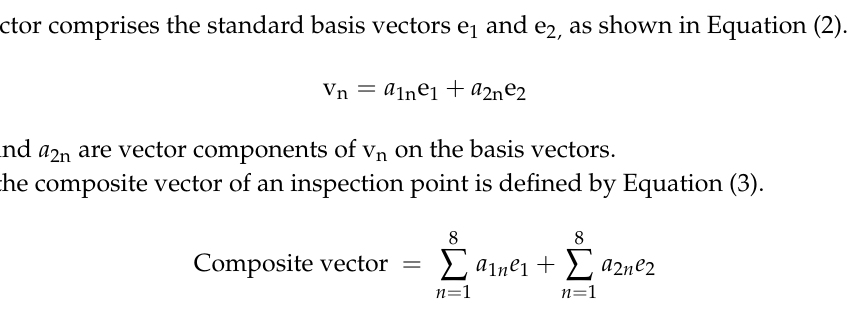
Figure 8. The Cartesian coordinate system of inspection points.